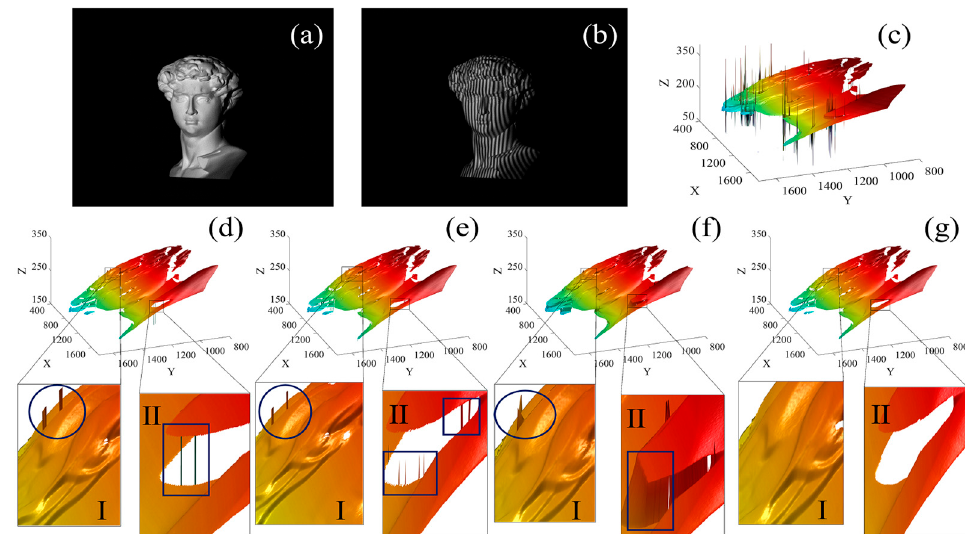
Figure 5. David statue model and its PUE-correction results using the comparison methods and the proposed method, respectively: ( a ) Original image; ( b ) Projected fringe pattern; ( c ) Unwrapped phase map obtained by Zhu’s method; ( d ) The unwrapped phase map corrected by Ding’s method; ( e ) The unwrapped phase map corrected by Song’s method; ( f ) The unwrapped phase map corrected by Lu’s method; ( g ) The unwrapped phase map corrected by the proposed method.